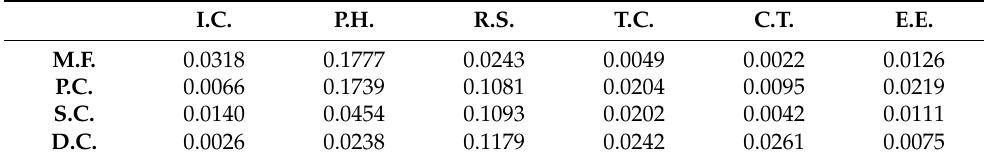
Table 13. Weighted normalized decision matrix for TOPSIS